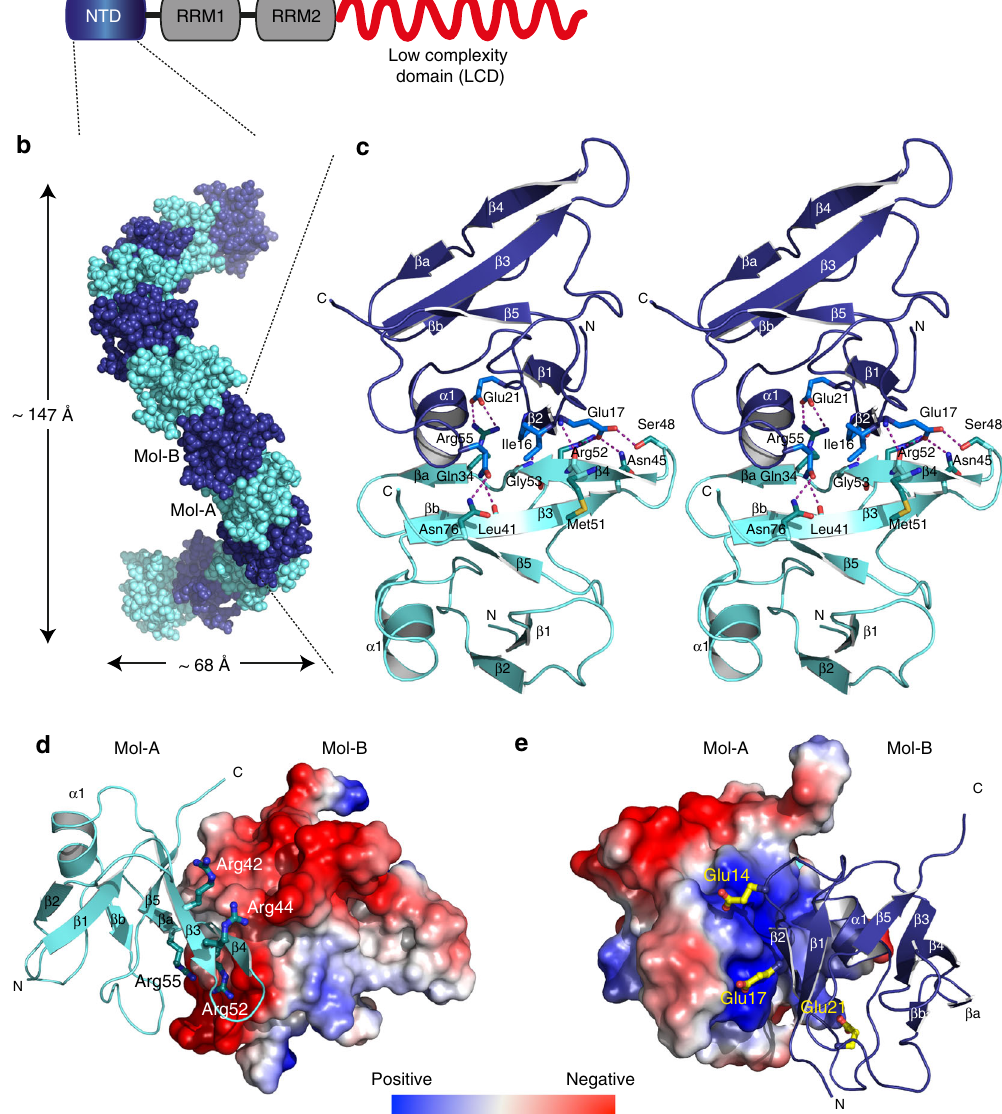
Fig. 2 Crystal structure of TDP-43 NTD at 2.1 Å resolution. a Schematic domain organization of human TDP-43 with the N-terminal domain ( NTD ) shown in blue , RNA recognition motifs ( RRMs ) in gray and the low-complexity domain ( LCD ) in red with domain boundaries indicated on top. b Crystals of TDP-43 NTD show helical fi laments with single molecules arranged in head-to-tail fashion as seen from the side. Atoms of Mol-A and -B (comprising asymmetric unit) are shown as cyan and blue spheres, respectively. The dimensions of the crystallographic helix are indicated. c Wall-eyed stereo view of two TDP-43 NTD molecules (Mol-A, Mol-B) in the asymmetric unit. The two molecules are shown in cartoon representation with the secondary structure elements and the N- and C-termini of the molecules labeled. The side chains making inter-molecular contacts are shown in stick representation in the corresponding domain color and labeled. Inter-molecular hydrogen bonds are shown as dotted magenta lines . Similar color and labeling schemes are used in other fi gures unless stated. d , e Electrostatic charge on the surface of two TDP-43 NTD molecules (Mol-A, Mol-B) of the asymmetric unit. Amino-acid residues in the positively charged head d and negatively charged tail region e are shown in stick representation and labeled. Positive potential is shown in blue and negative potential in